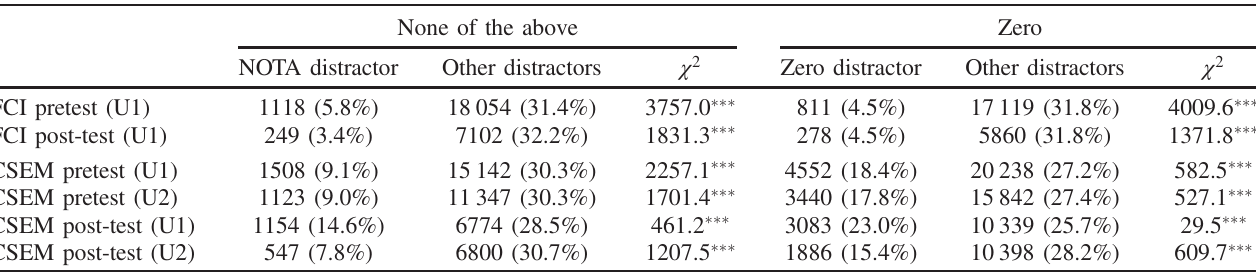
TABLE III. Total number and percentage of students selecting the testwiseness-affected distractor and other distractors in questions which have a NOTA distractor or zero distractor in data sets 1 and 3. For “ other distractors, ” the number is the total number of selections for all three other distractors and the percentage is the average percentage for one of the three. Superscripts * denotes p < 0 . 05 , ** denotes p < 0 . 01 , and *** denotes p < 0 . 001 based on a χ 2 test of difference from a random distribution. None of the